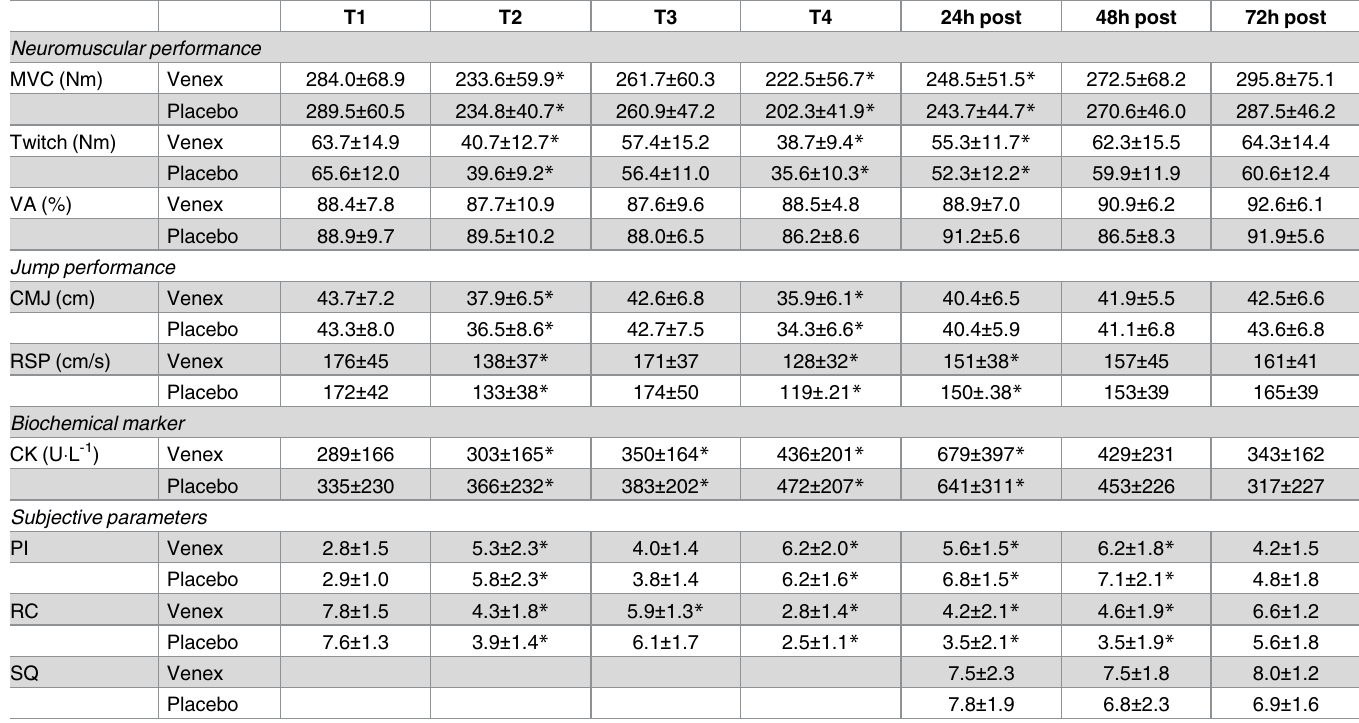
Table 1. Mean ± SD data from neuromuscular tests, jump performance, the biochemical markerand subjective